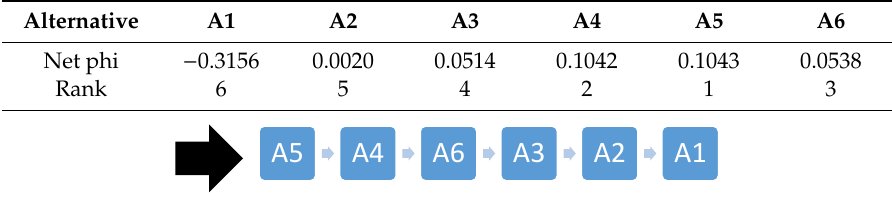
Table 14. Baseline results. Table 15. Baseline results.